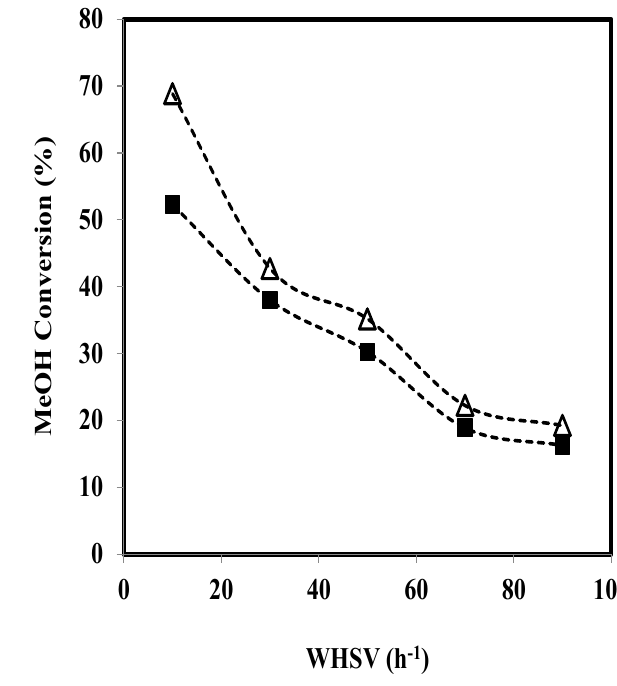
Fig. 4. Methanol conversion versus WHSV at 290 o C and 320 o C (∆) in the fixed bed reactor for particle size of 0.125<P.S. <0.5mm. Dotted lines show the trend of changes..